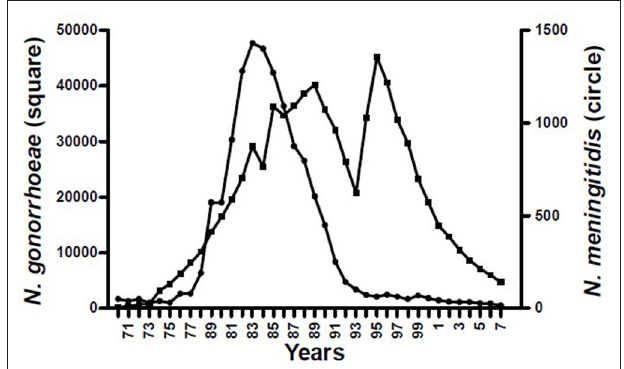
FIGURE 1 | Morbidity of Neisseria pathogenic species in Cuba 1970–2007 (8).